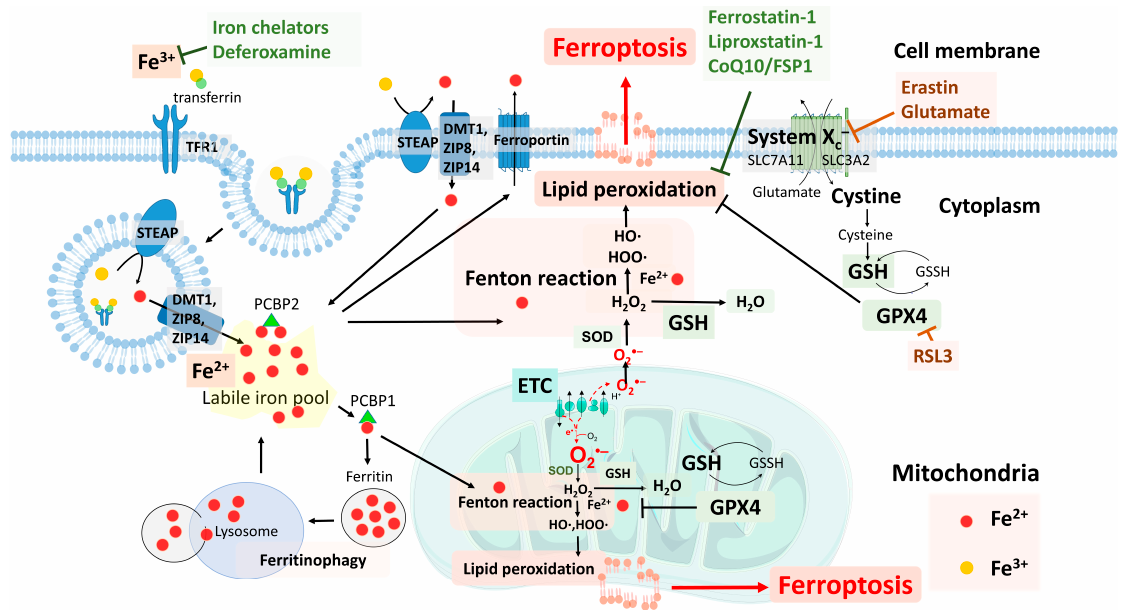
Figure 1. Regulatory pathways of ferroptosis. The iron metabolism (left) includes the endosomal uptake of ferritin-bound Fe 3+ , Fe 3+ conversion to Fe 2+ via STEAP proteins, Fe 2+ release through the transporters DMT1 and ZIP8/14, and Fe 2+ distribution to different intracellular regions via the chaperones, including PCBP1 and PCBP2. Iron is delivered to the labile iron pool, imported into the mitochondria, stored in ferritin, etc. In low-iron situations, the degradation of ferritin through ferritinophagy occurs and releases the ferritin-bound iron into the cytoplasm. In the case of excess iron, the iron is exported by ferroportin. The mitochondrial ETC generate O2—which is reduced to H 2 O 2 by the antioxidant SOD. The H 2 O 2 under the catalysis of Fe 2+ from the labile iron pool participates in the Fenton reaction, creating hydroxyl radicals, which further activates lipid peroxidation, leading to ferroptosis. The system x c − /GSH/GPX4 axis (right) exerts antioxidative effects to prevent